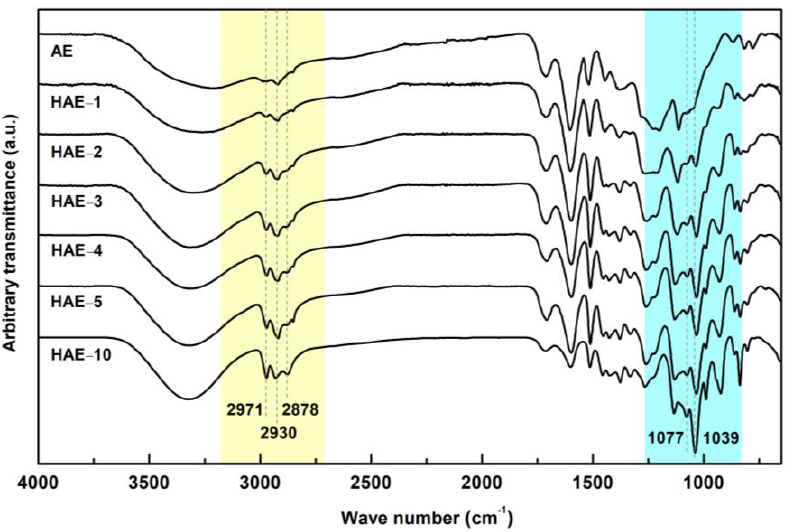
Figure 3. FT-IR spectra of AE and